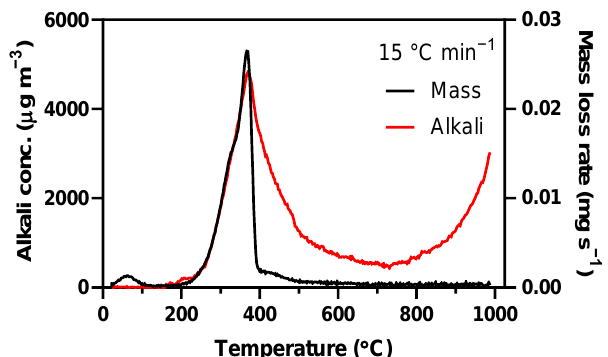
Figure 6. The mass loss rate (black line) and alkali concentration (red line) as a function of temperature during biomass pyrolysis in N 2 at a heating rate of 15 °C min −1 .